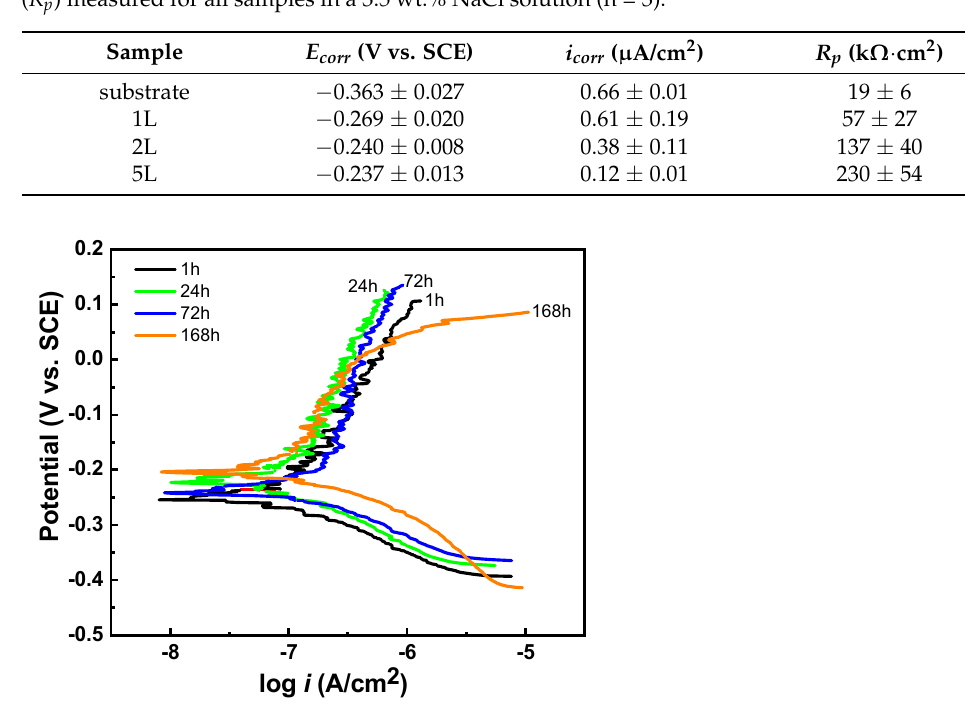
Figure 7. Potentiodynamic polarization curves of 5L films immersed in a 3.5 wt.% NaCl solution for 1, 24, 72, and 168 h. Table 3. Corrosion potential ( E corr ), corrosion current densities ( i corr ), and LPR polarization resistance ( R p ) measured for a 5L film in 3.5 wt.% NaCl at various immersion times (n =